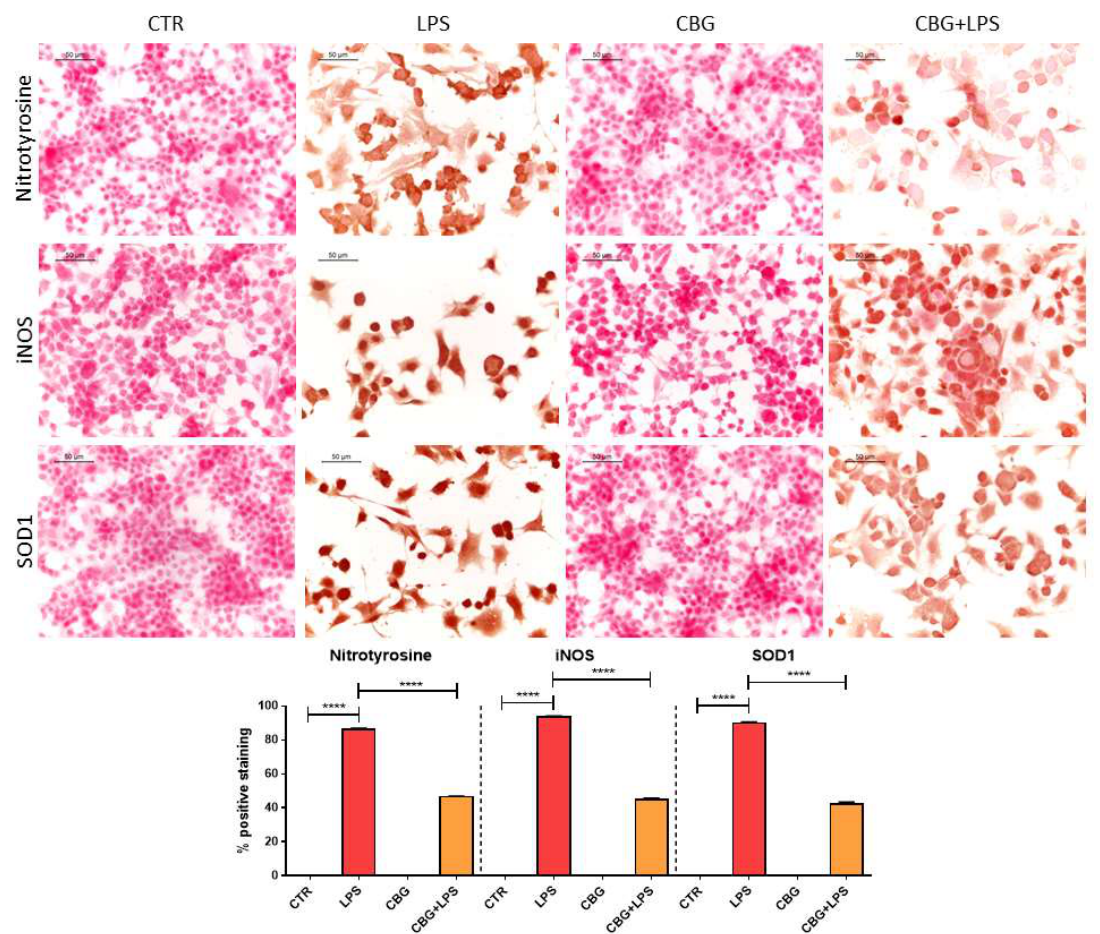
Figure 5. CBG pre-treatment was able to reduce the levels of oxidative stress markers nitrotyrosine, iNOS and SOD1 in NSC-34 cells treated with the medium of LPS-stimulated RAW 264.7 macrophages. The treatment with the medium of LPS-stimulated RAW 264.7 macrophages induced the expression of nitrotyrosine, iNOS and SOD1, but CBG pre-treatment reduced their levels. The immunocytochemical assays were repeated three times. **** p < 0.0001, NSC-34 cells treated with the medium of LPS stimulated macrophages vs. NSC-34 cells pre-treated with CBG and then exposed to the medium of LPS stimulated macrophages, NSC-34 cells treated with the medium of LPS stimulated macrophages vs. control; Scale bar: 50 µm.